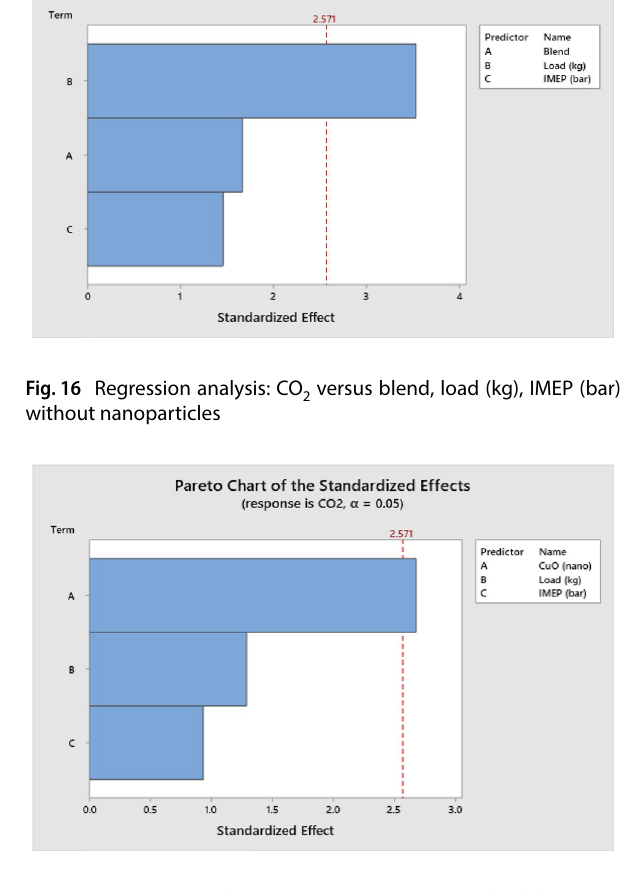
Fig. 17 Regression analysis: CO (bar) with nanoparticles Fig. 18 Residual plot for CO without